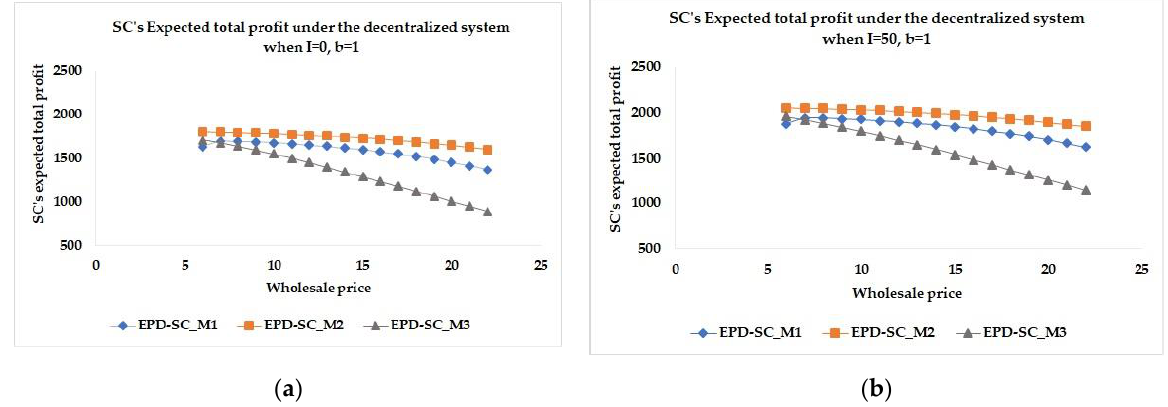
Figure 4. The supply chain’s expected total profits of Model 1, Model 2, and Model 3 under the decentralized system with different values of w , where b = 1 and ( a ) I 0 = 0; ( b ) I 0 = 50.